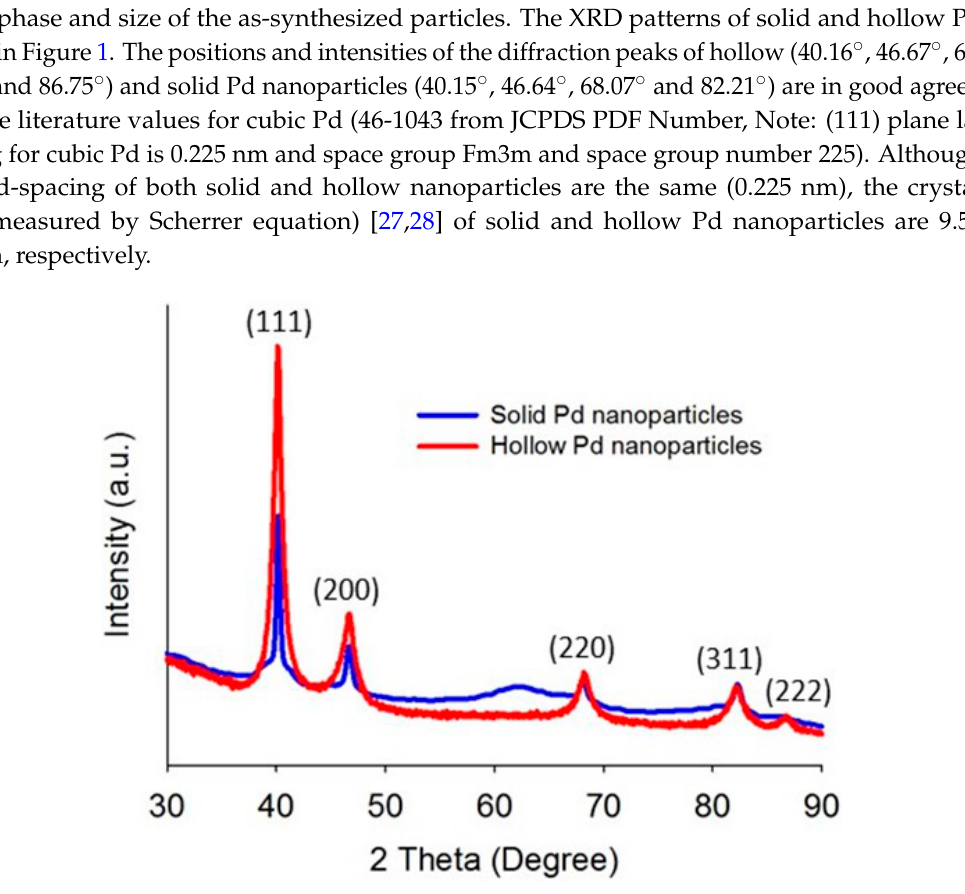
Figure 1. XRD patterns of solid and hollow Pd nanoparticles.